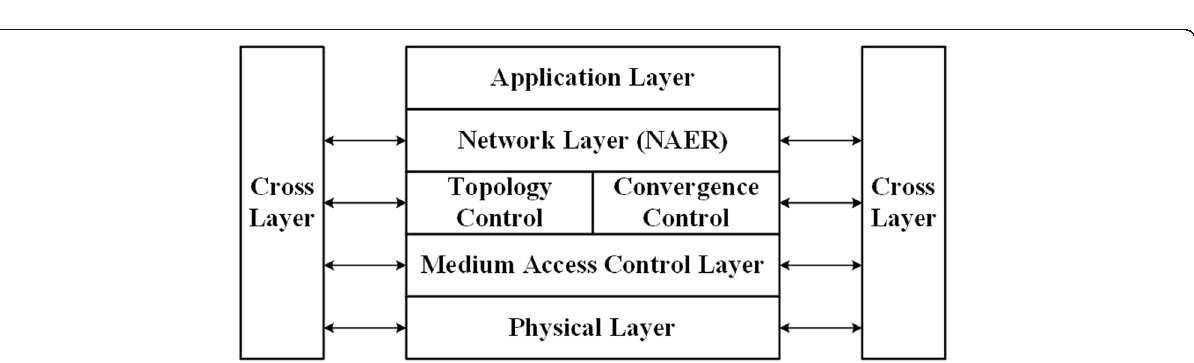
Fig. 11 Principle of cross layer interactions in NAER. Figure 11 gives the principle of cross layer interaction from the perspective of protocol